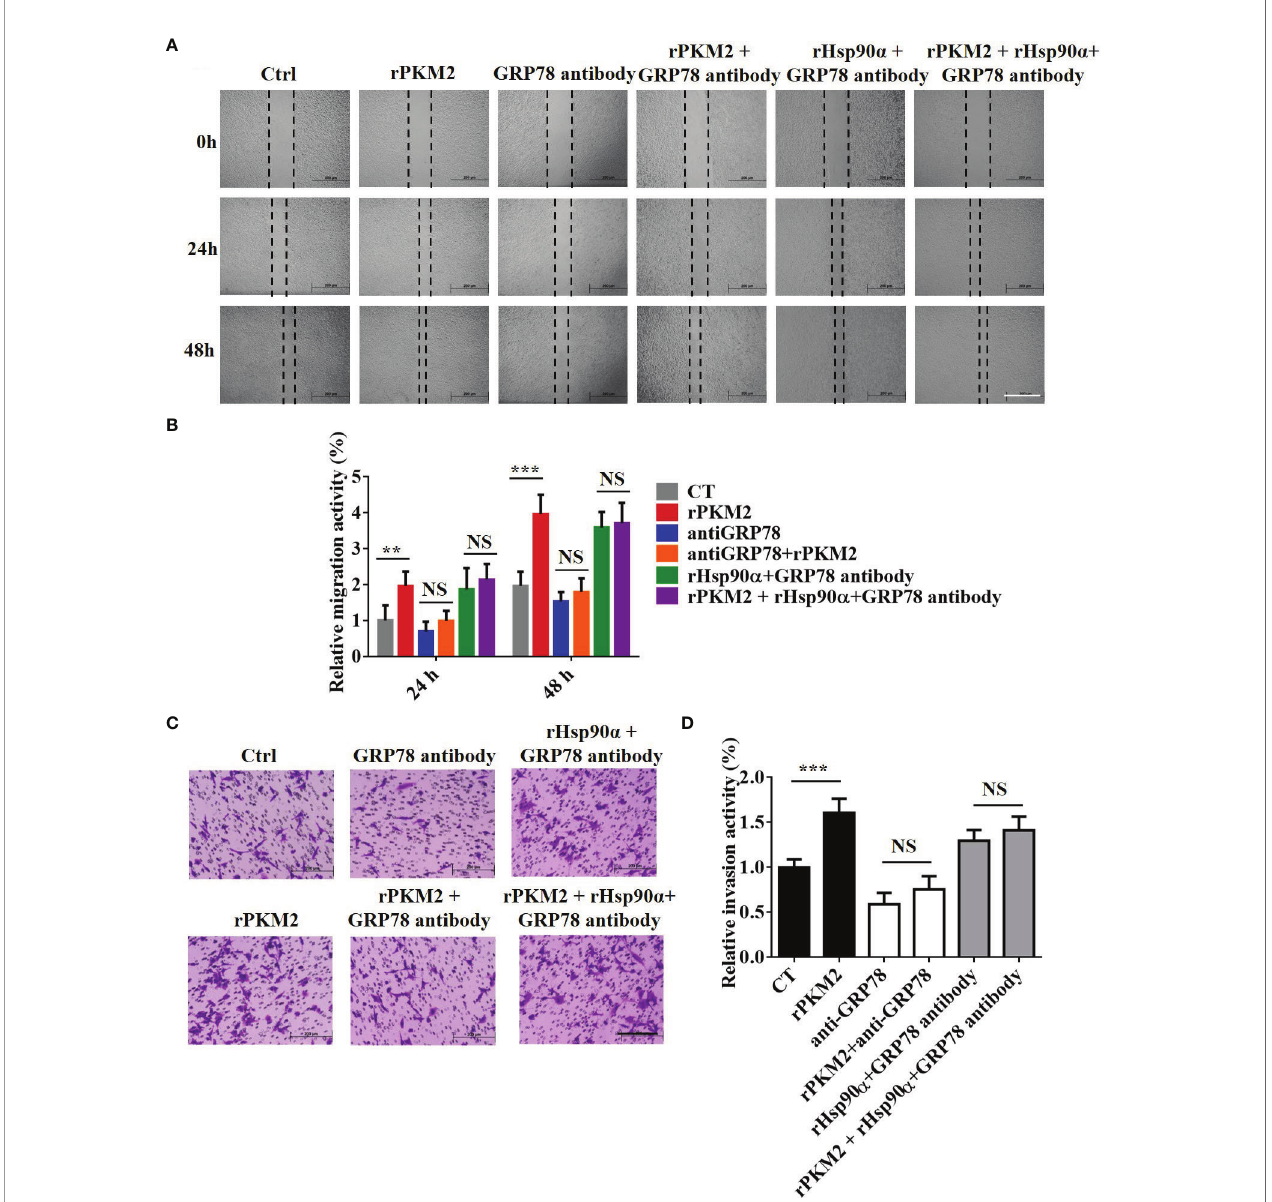
FIGURE 7 | GRP78 mediates secreted PKM2-facilitated tumor migration and invasion. (A) Representative images of A549 migration assay (scale bar, 200 m m) with (i) PBS, (ii) rPKM2, (iii) anti-GRP78, (iv) anti-GRP78 and rPKM2 combination, (v) rHsp90 a and anti-GRP78 combination, and (vi) rHsp90 a , rPKM2, and anti-GRP78 combination. (B) Quanti fi ed results of A549 migration assay with (i) PBS, (ii) rPKM2, (iii) anti-GRP78, (iv) anti-GRP78 and rPKM2 combination, (v) rHsp90 a and anti-GRP78 combination, and (vi) rHsp90 a , rPKM2, and anti-GRP78 combination. (C) Representative images of A549 invasion assay (scale bar, 200 m m) with (i) PBS, (ii) rPKM2, (iii) anti-GRP78, (iv) anti-GRP78 and rPKM2 combination, (v) rHsp90 a and anti-GRP78 combination, and (vi) rHsp90 a , rPKM2, and anti-GRP78 combination. (D) Quanti fi ed results of A549 invasion assay with (i) PBS, (ii) rPKM2, (iii) anti-GRP78, (iv) anti-GRP78 and rPKM2 combination, (v) rHsp90 a and anti-GRP78 combination, (vi) rHsp90 a , rPKM2, and anti-GRP78 combination. Data are represented as mean ± SD. NS, not signi fi cant; ** p < 0.01; *** p < 0.001, two-tailed Student ’ s t tests; n = 3 biological